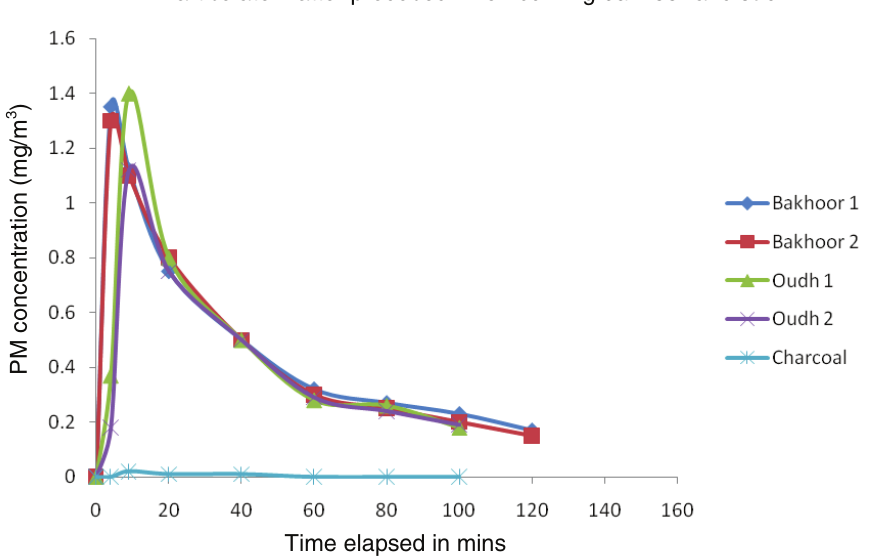
Many pathogens such as bacterial droplets, viral droplets, and fun- gal spores remain suspended in the household air after an infection in the family. These droplets settle on household surfaces, acting as fomites for the spread of